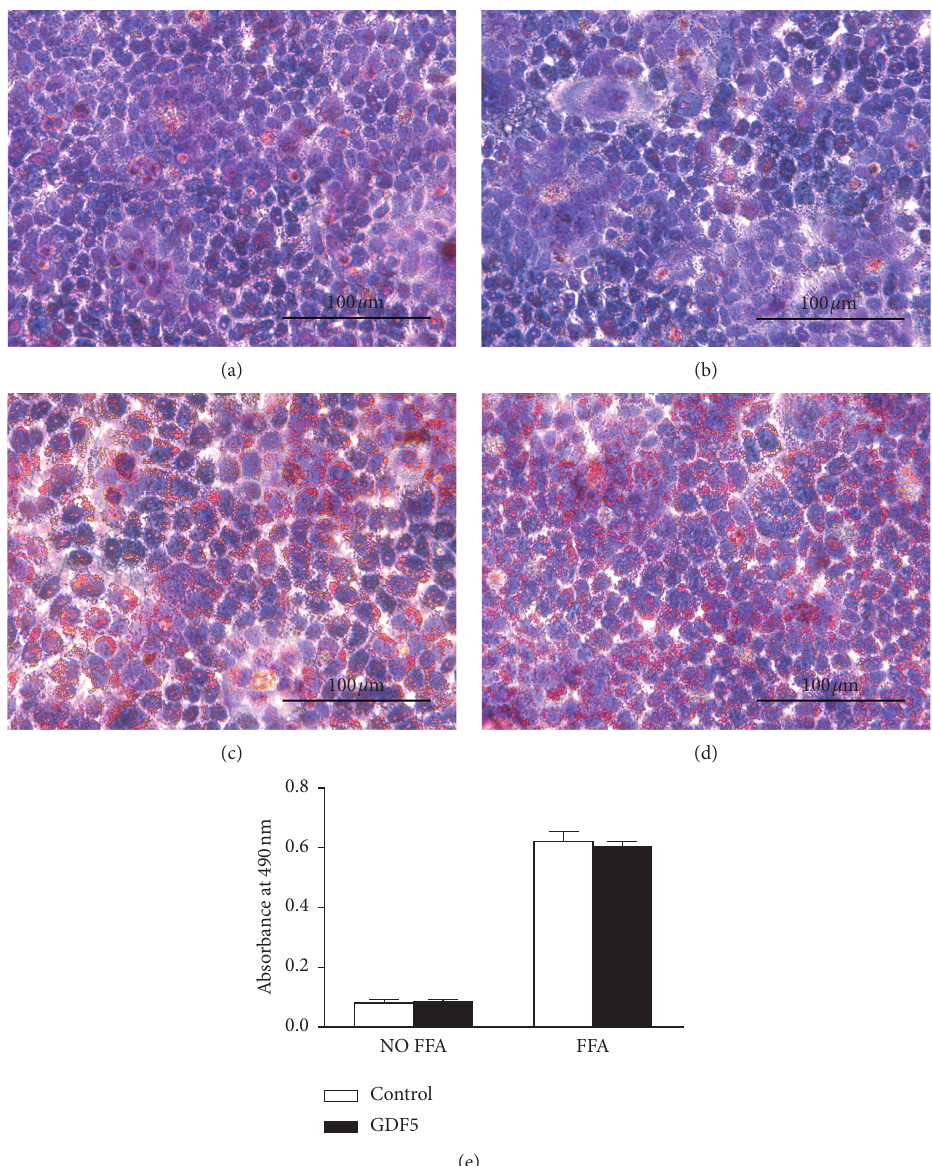
Figure 3: Oil Red O staining of LO2 cell groups with/without FFA treatment (1 mmol/L). (a) LO2 control cells without FFA treatment. (b) Overexpression of GDF5 without FFA treatment. (c) LO2 control cells with FFA treatment. (d) Overexpression of GDF5 with FFA treatment (scale: 100 μ m). (e) Quantitative analysis of Oil Red O staining ( ∗ : P < 0 . 05; ∗∗ : P < 0 .